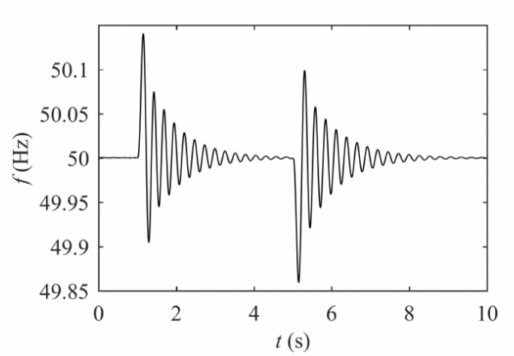
Figure 4. Diesel engine frequency curve.